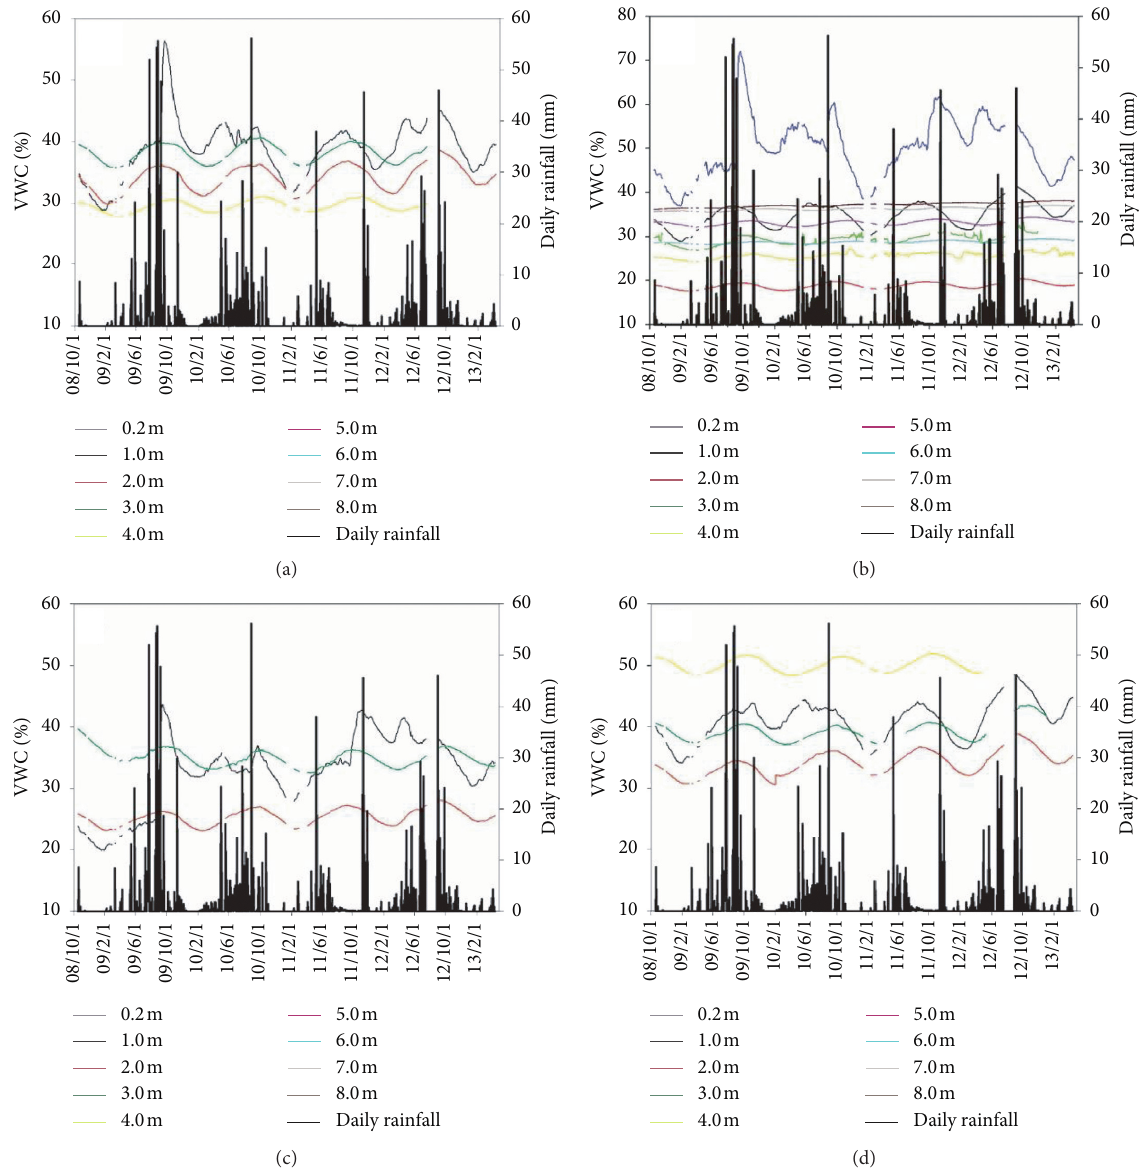
Figure 4: Relationship between daily soil VWC and rainfall: (a) TDR1; (b) TDR2; (c) TDR3; (d)